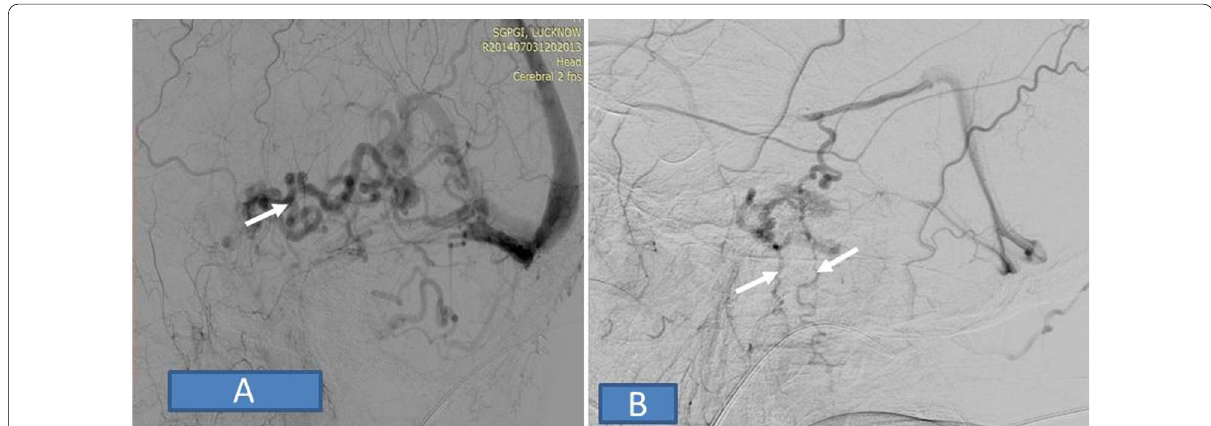
Fig. 5 dAVF—Cognard classification; a Type IIb—showing cortical venous reflux (white arrow), b Type V—spinal perimedullary venous drainage (white